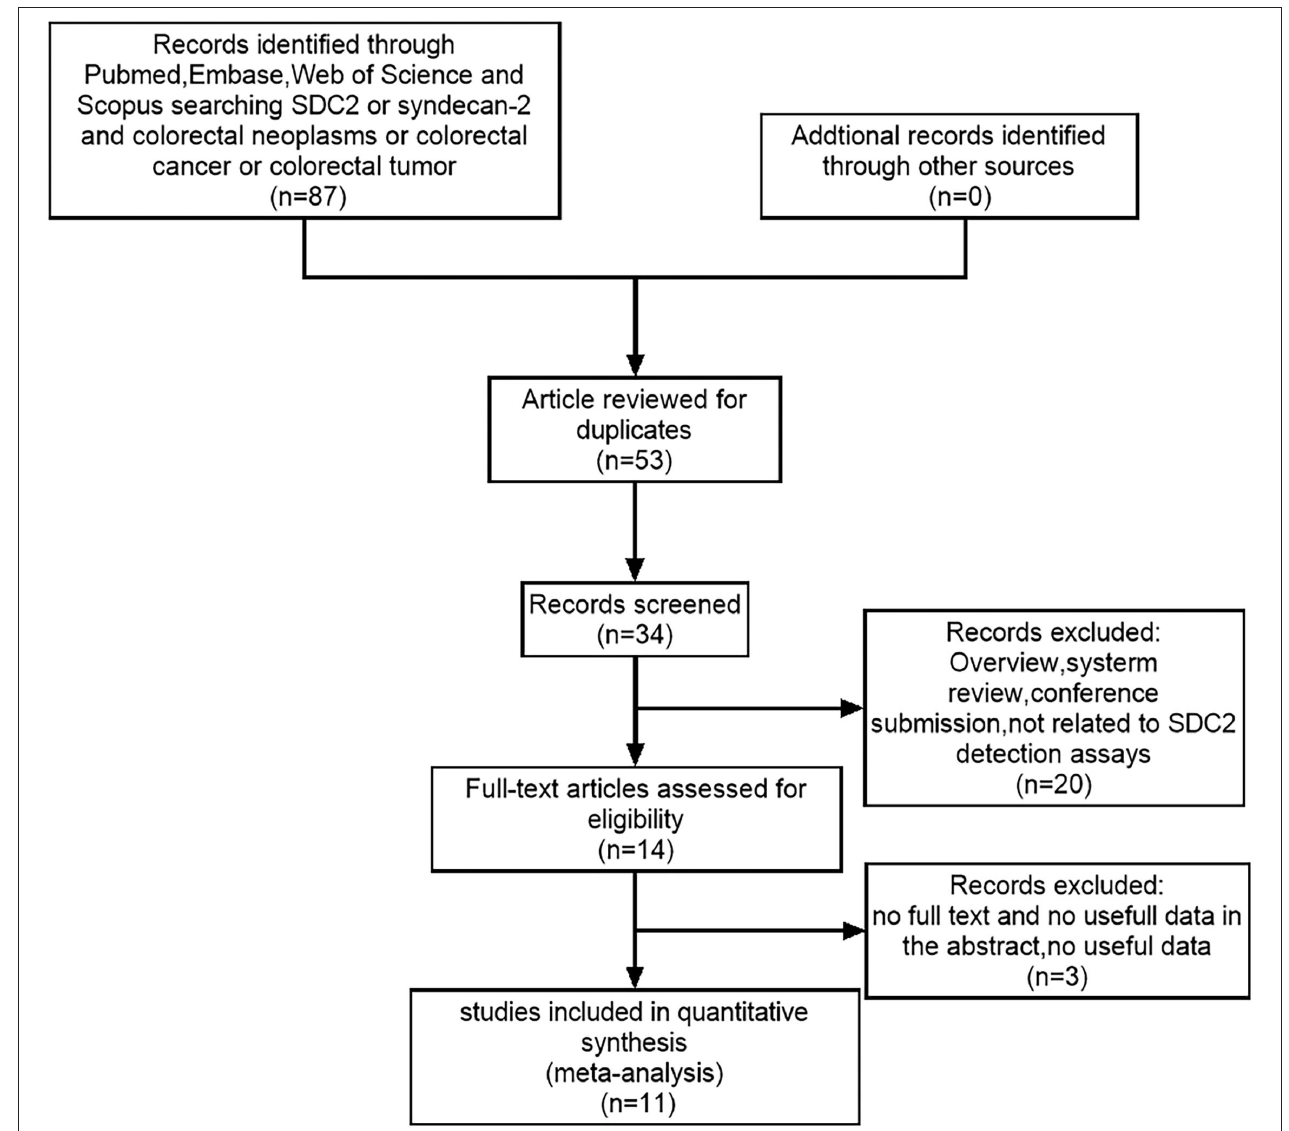
FIGURE 3 | The PRISMA flow diagram for literature selection from relevant studies for this meta-analysis. The design of the diagram and the screening of the literature were based on the PRISMA statement for reporting